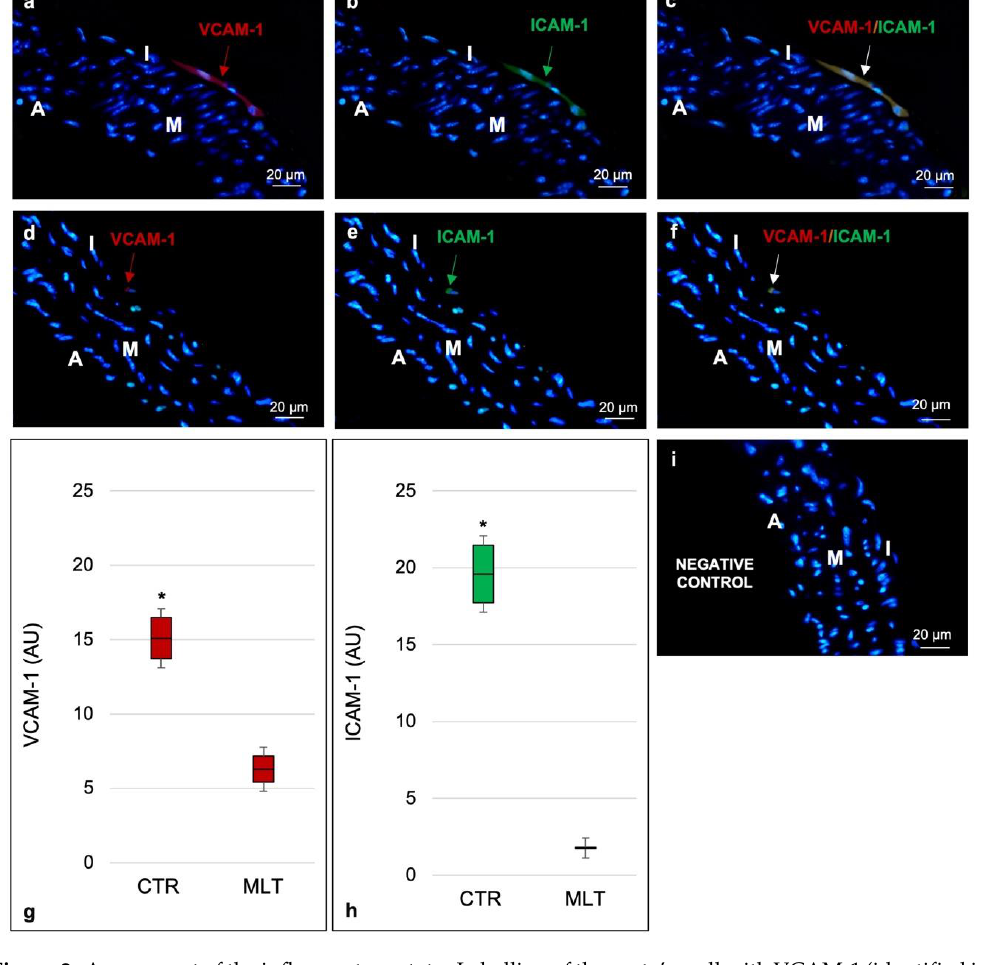
Figure 2. Assessment of the inflammatory state. Labelling of the aorta’s wall with VCAM-1 (identified in red staining, panels ( a ) and ( d ) and ICAM-1 (identified in green staining, panels ( b ) and ( e ) considering them as general markers of the inflammatory state. Each panel shows a full-field image at 400 × (scale bars: 20 µ m). Double immunofluorescence photomicrograph of the control mice shows a moderate expression of both adhesion proteins (merged expression reported in panel ( c ). In contrast, the double immunofluorescence photomicrograph of ApoE - / - mice treated with melatonin highlights, for the same inflammatory markers, an absent / very weak positivity at the tunica intima level (merged expression reported in panel ( f ). Graphs summarize, as arbitrary units, the positivity, respectively, of VCAM-1 ( g )andICAM-1( h )obtained, forbothadhesionmolecules,